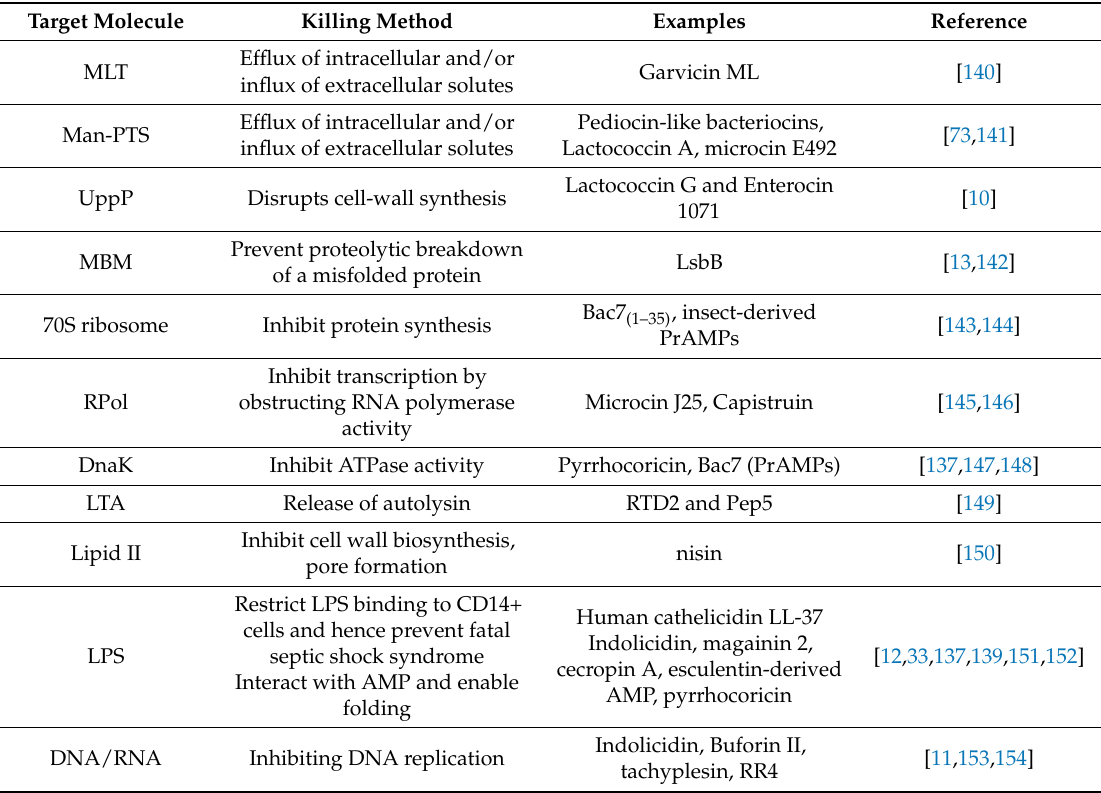
Table 1. Characterized AMP targets and their killing